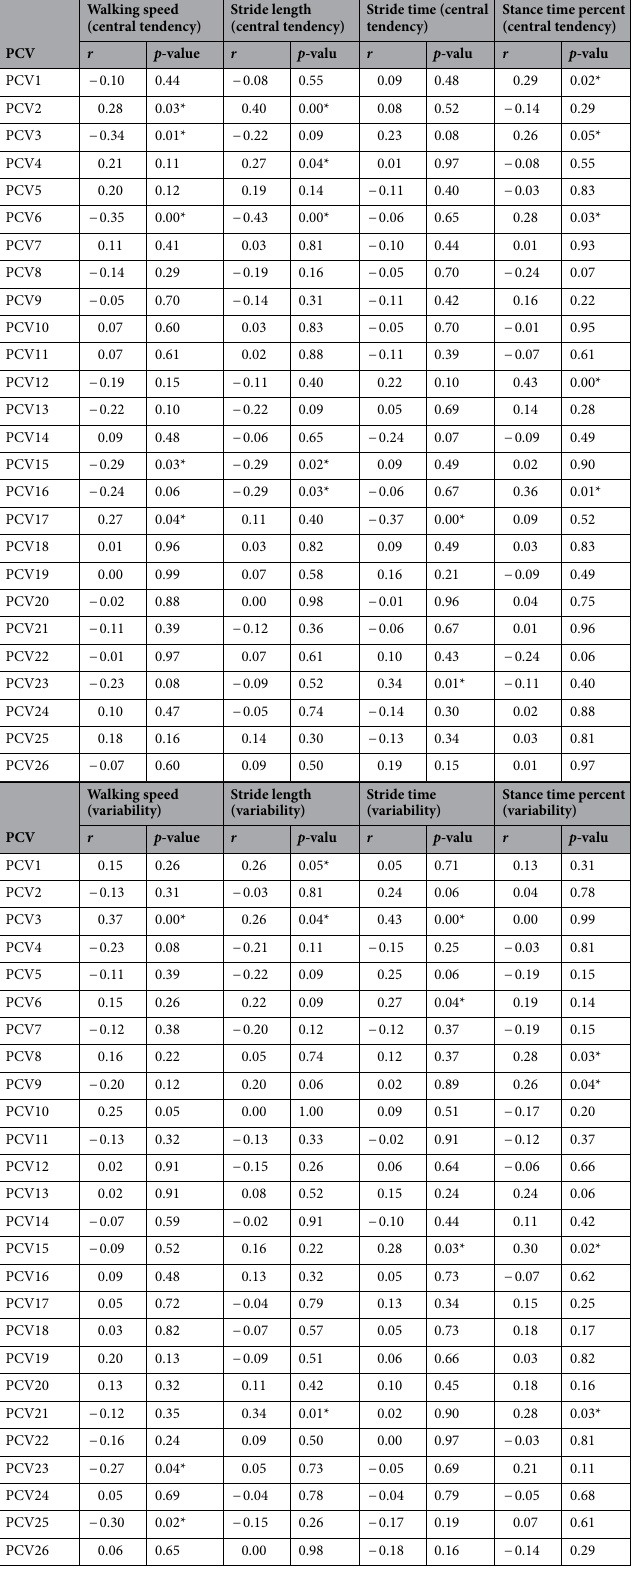
Table 4. Correlation coefficients between the spatiotemporal parameters and principal component vectors. We calculated the Pearson’s product-moment correlation coefficients between the principal component vectors that were related to frailty status and the spatiotemporal parameters. PCV principal component vector, r Pearson’s product-moment correlation coefficients. The “*” symbol indicates significant correlations (* p <